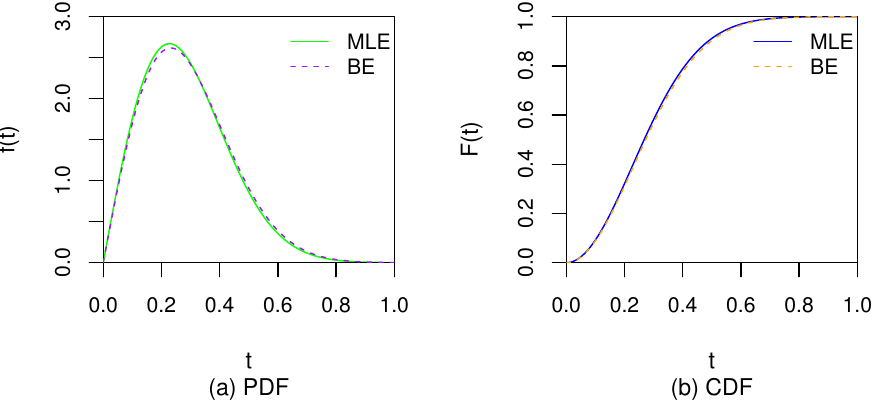
Figure 2. The PDF and CDF plots based on MOBR distribution with MLEs and BEs under Dataset 2. Table 11. Estimates for unknown parameters under high-voltage power transformers data.